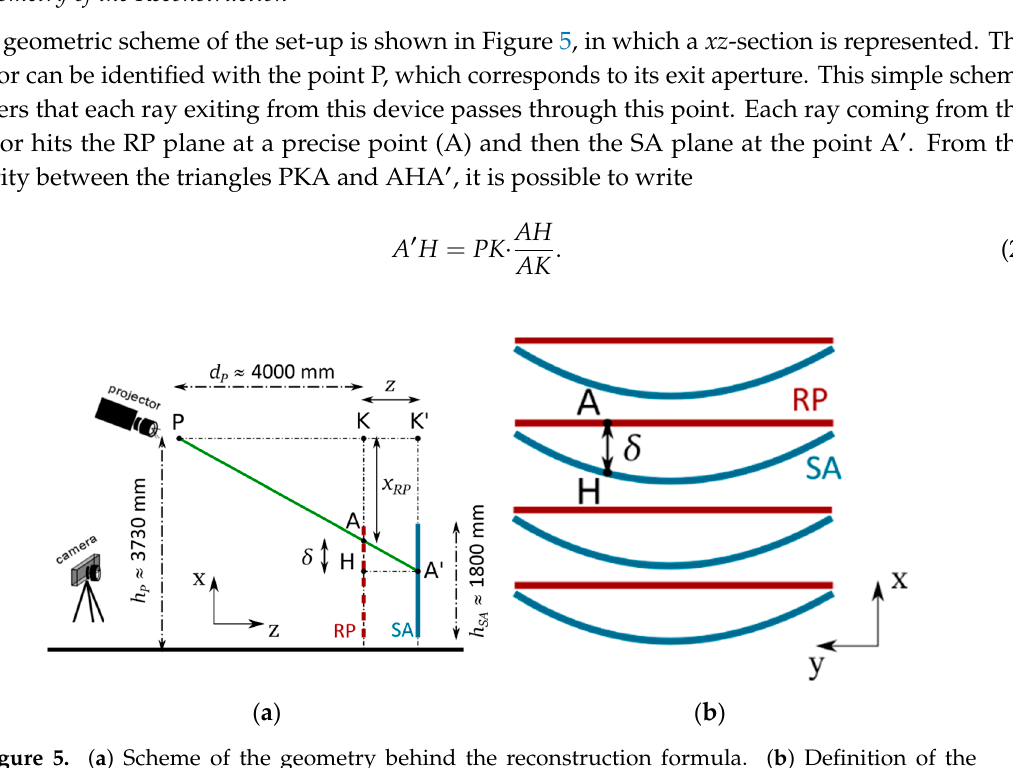
Figure 5. ( a ) Scheme of the geometry behind the reconstruction formula. ( b ) Definition of the deformation, as the distance (along the x -axis) between the line projected on reference plane (RP) (red line) and the line on mirror sample (SA) (blue